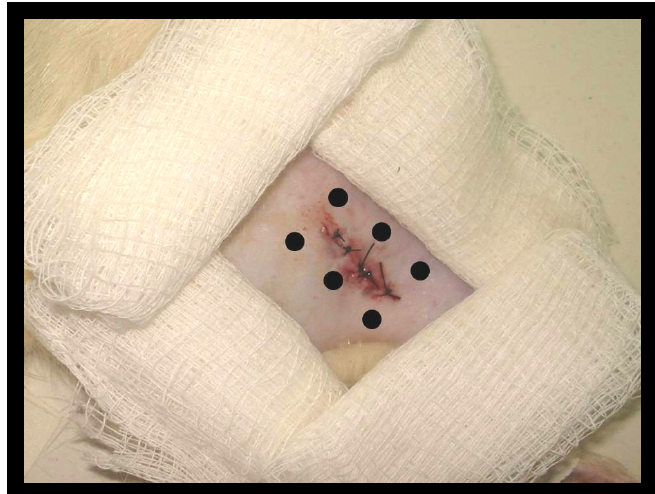
FIGURE 3 – Laser application points through transcutaneous method. Source: Fieldwork archive,